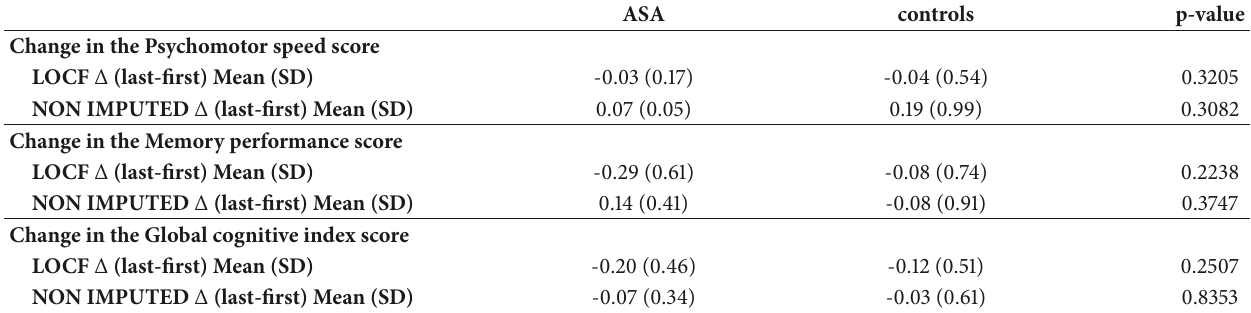
Table 5: Secondary endpoint-b: change (last follow-up versus baseline) in cognitive indexes.